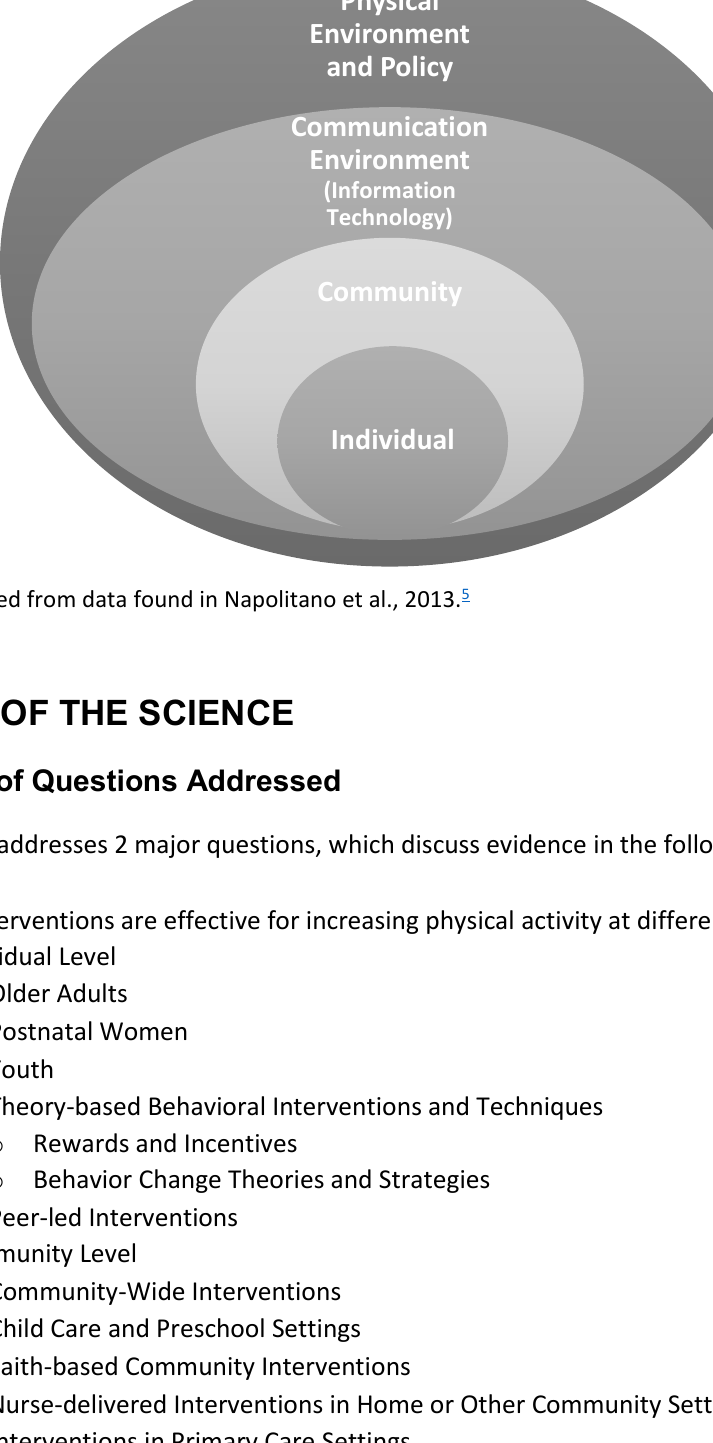
Figure F11-1. Social Ecological Framework